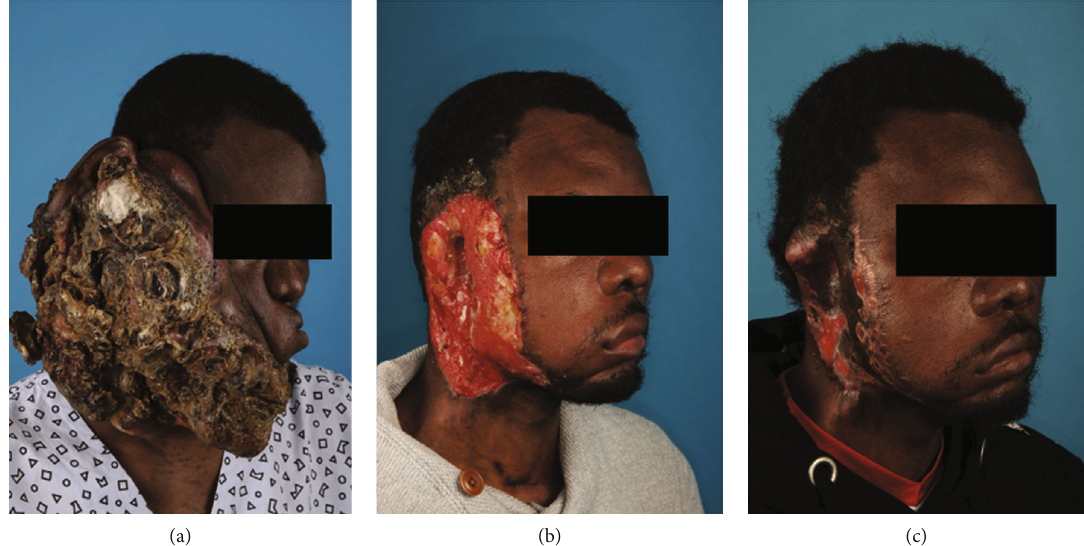
Figure 1: Photographs of a large right-sided facial necrotizing mass causing facial dis fi gurement after successive treatment. (a) Initial presentation. (b) After reconstruction of fi rst tumour debulking with cutaneous allograft. (c) After reconstruction of the second debulking with split-thickness skin graft.